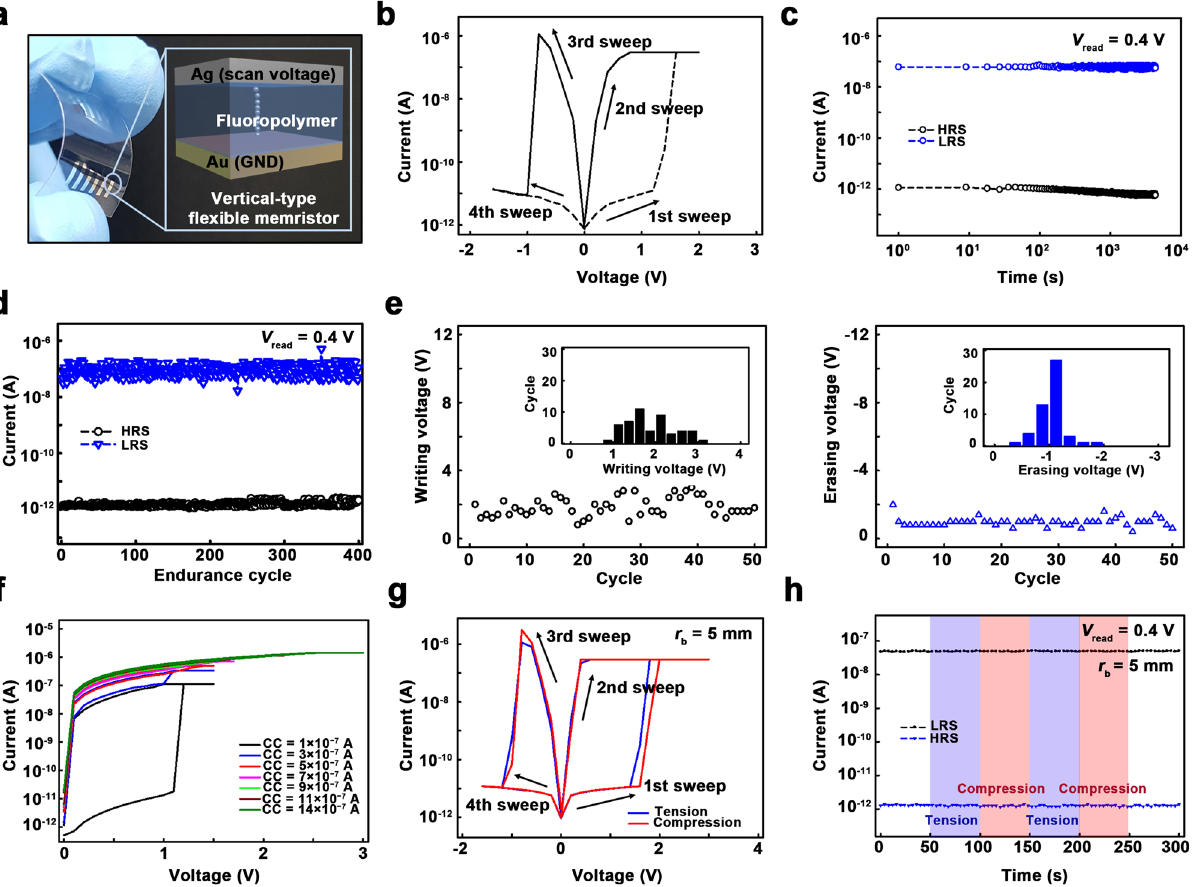
Fig. 2 Electro-mechanical characteristics of the fl uoropolymer-based fl exible memristor. a Photographic image of the vertical-type fl exible memristor under bending deformation. Inset image shows a structure of the memristor. The thickness of the polymer fi lm was about 280 nm, and the active area of the device was 0.5 mm × 0.5 mm. b Current – voltage ( I – V ) curves of the device. c Retention performances of the device. d Electrical endurance characteristics of the device. e Distributions of the switching voltages of the device in the repeated cycle